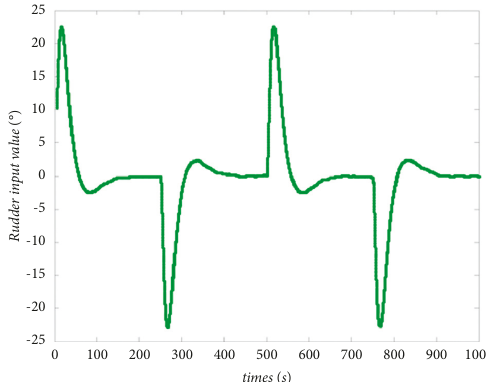
Figure 4: The results of heading output in the